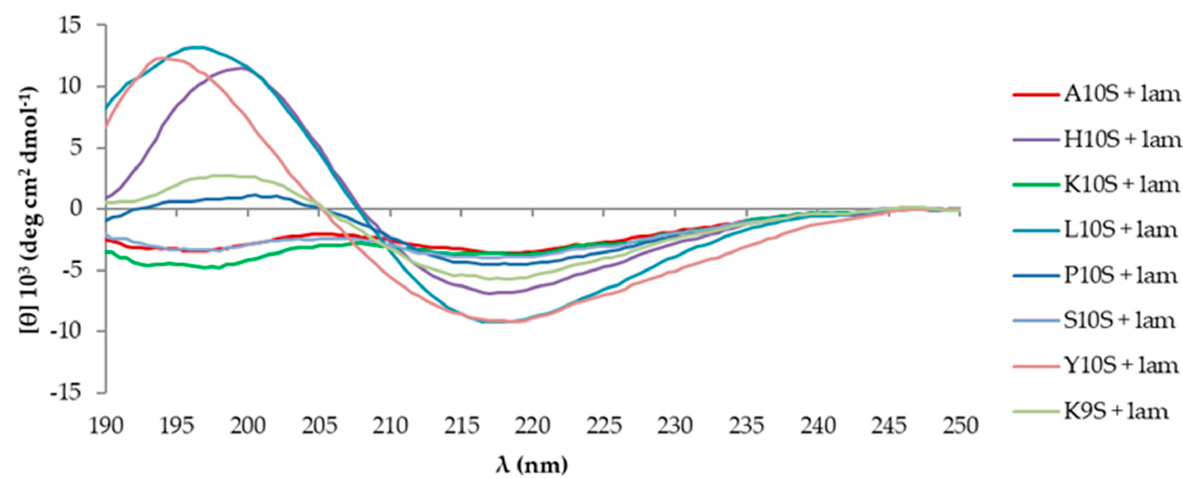
Figure 3. Far UV-CD spectra of 100 µM KP (A10S) and KP-derivatives acquired at 20 °C in the presence of laminarin (500 µM) immediately after preparation of the starting aqueous solution (1 mM).